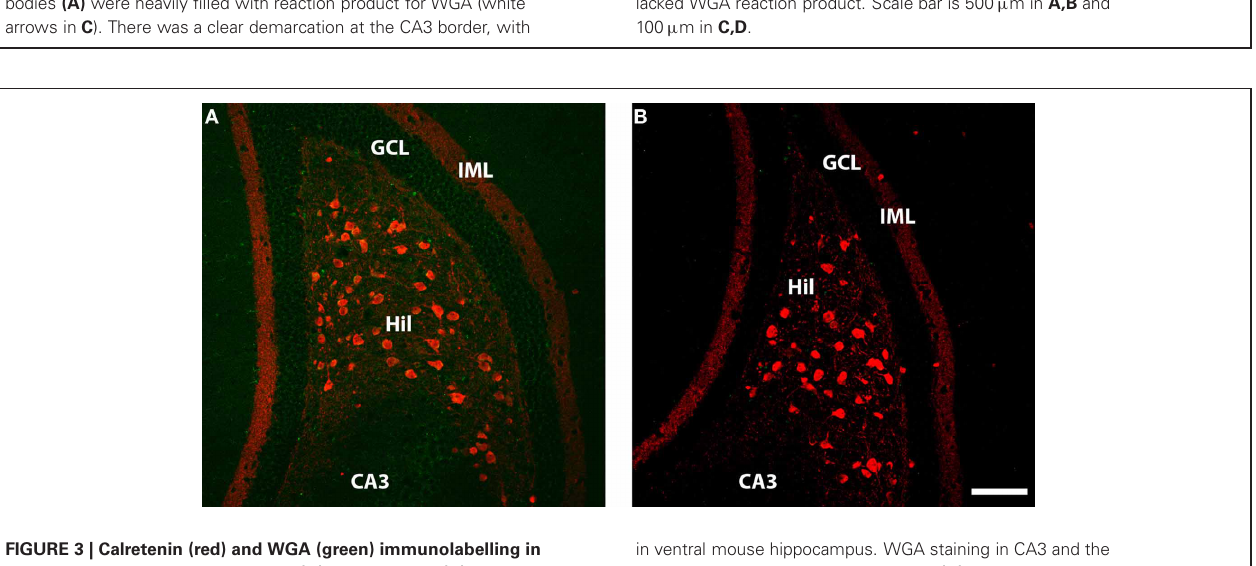
adjacent pyramidal neurons lacking reaction product (black arrows). Pyramidal neurons throughout the hippocampus of wild type mice